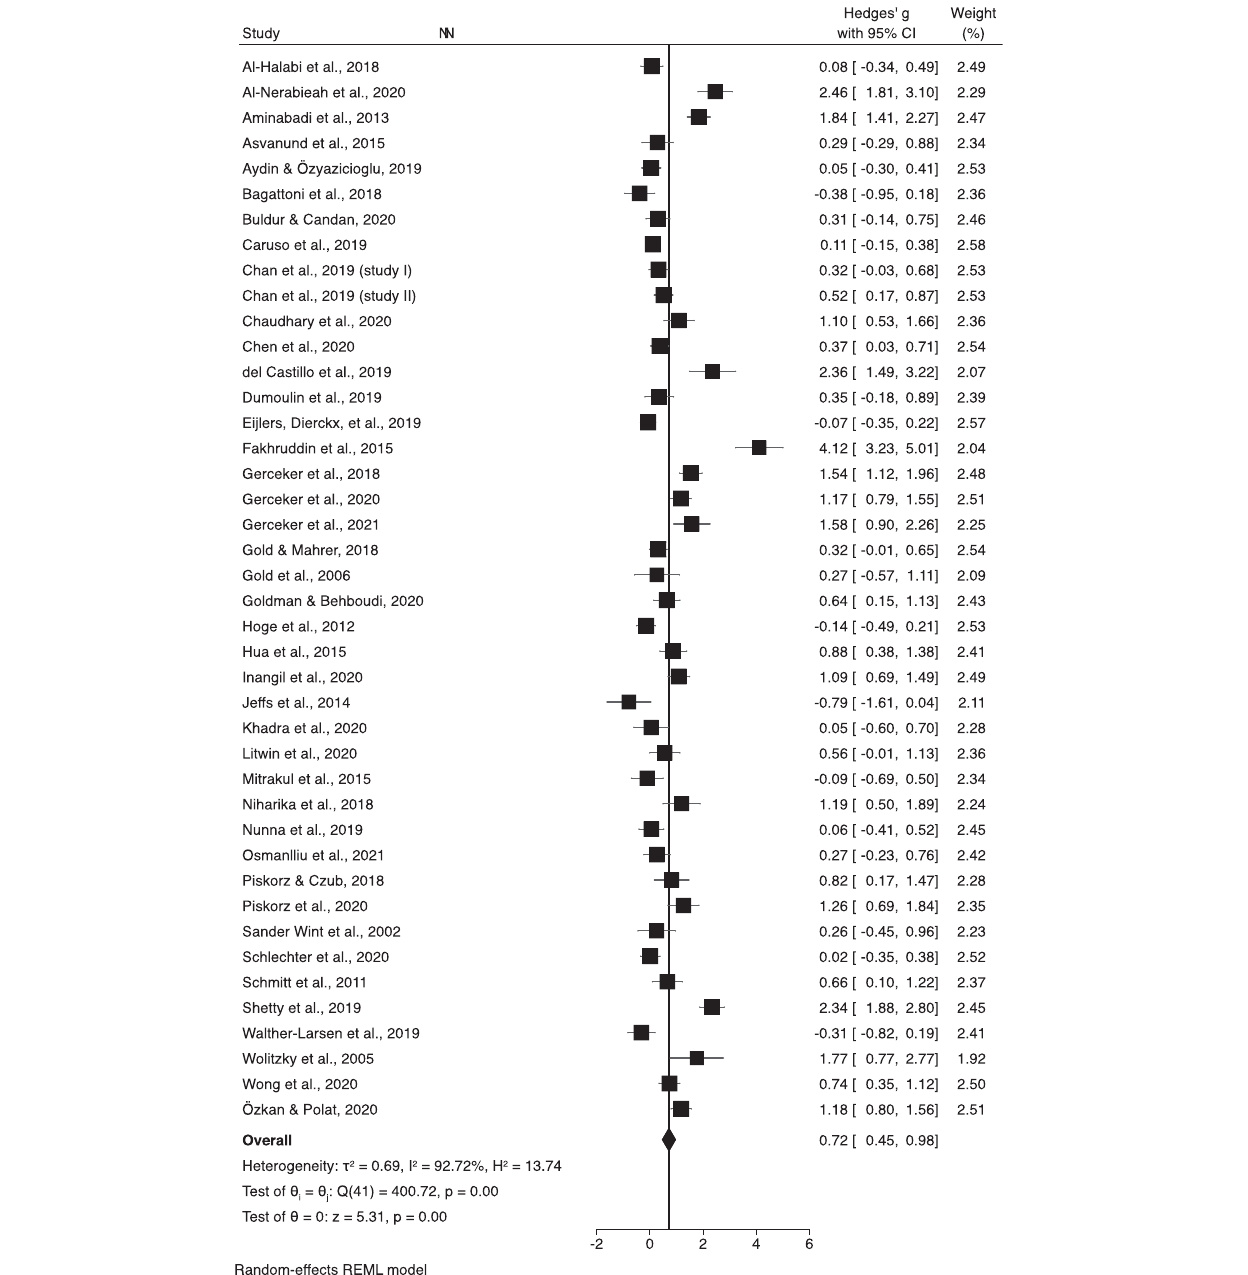
FIGURE 6 | Forest plot of individual and combined results from studies reporting pain outcomes.